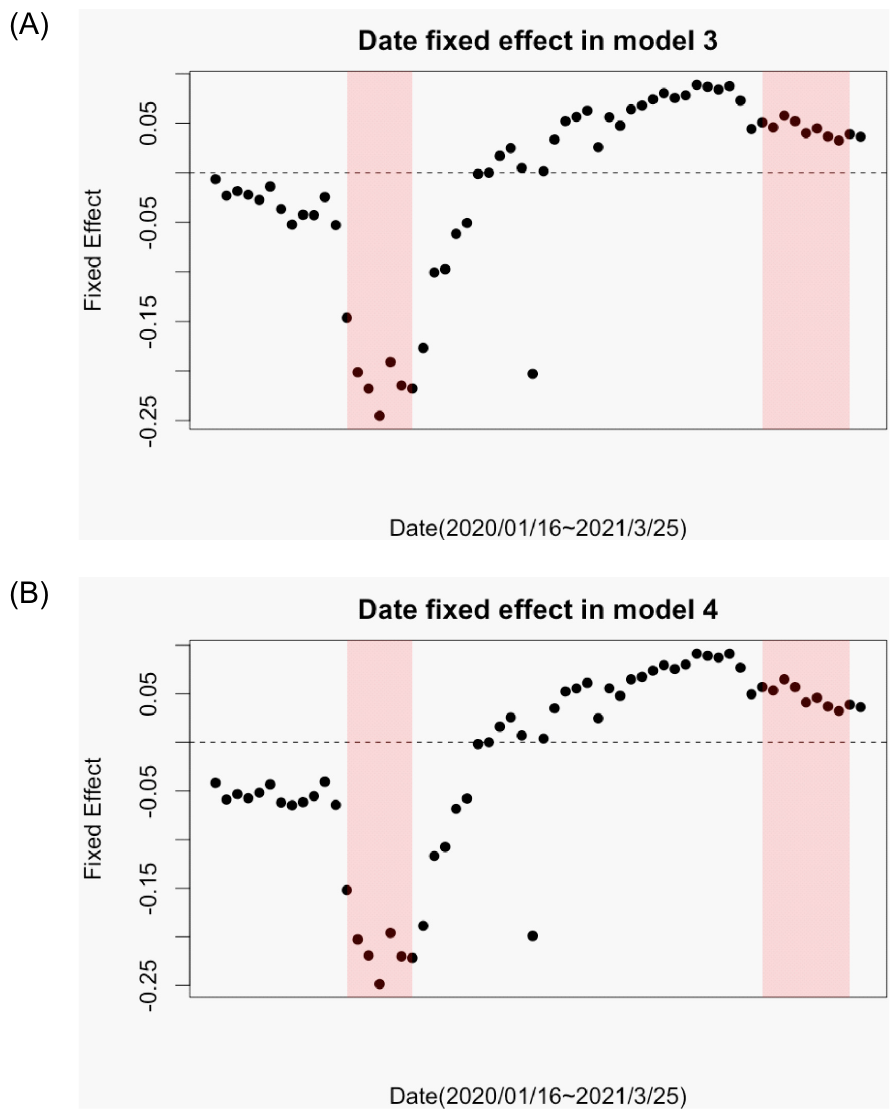
Fig 9. Date fixed effect: (A) in Model 3 and (B) in Model 4. In both figures, date fixed effect significantly decreases around April, 2020.